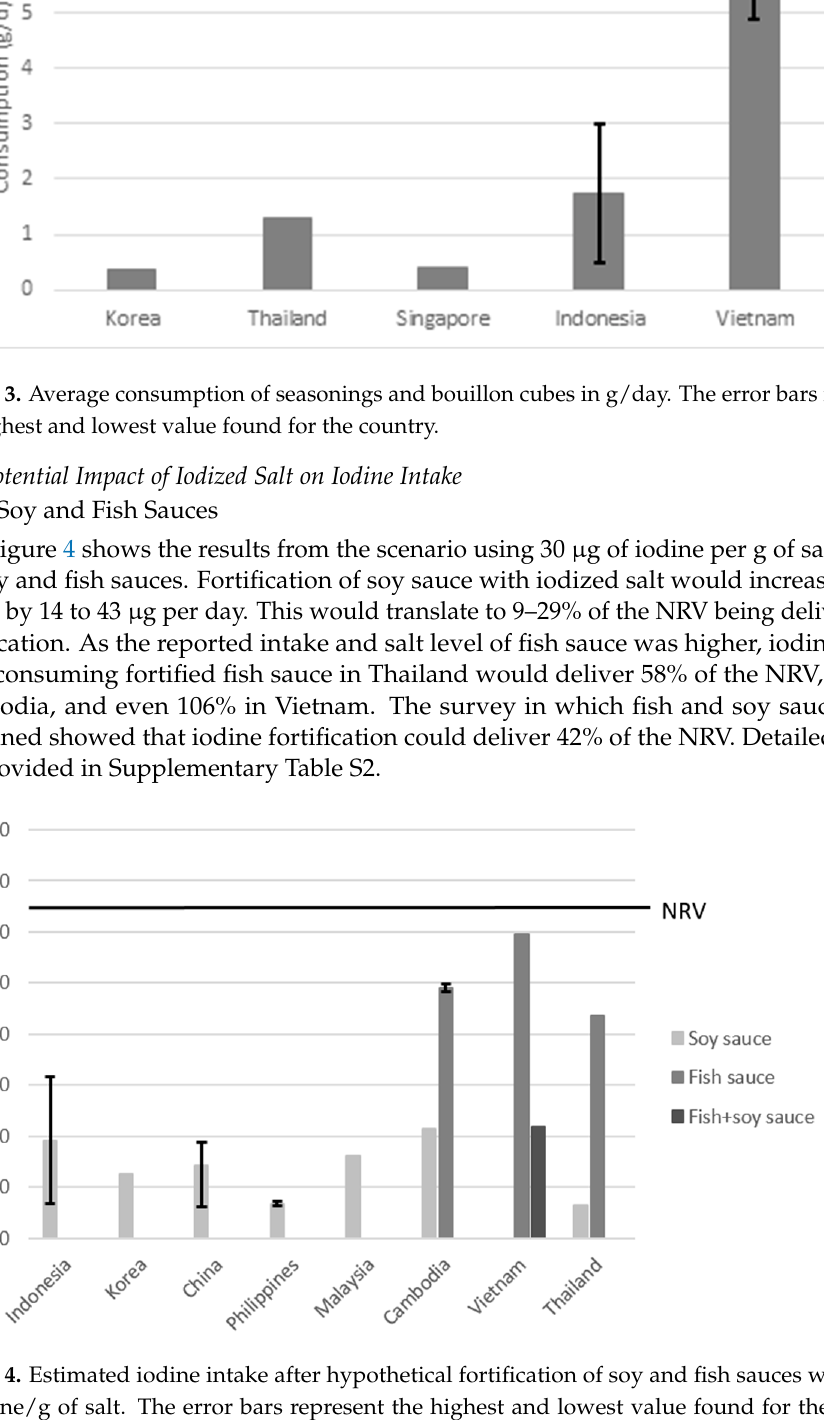
Figure 3. Average consumption of seasonings and bouillon cubes in g/day. The error bars represent the highest and lowest value found for the country.